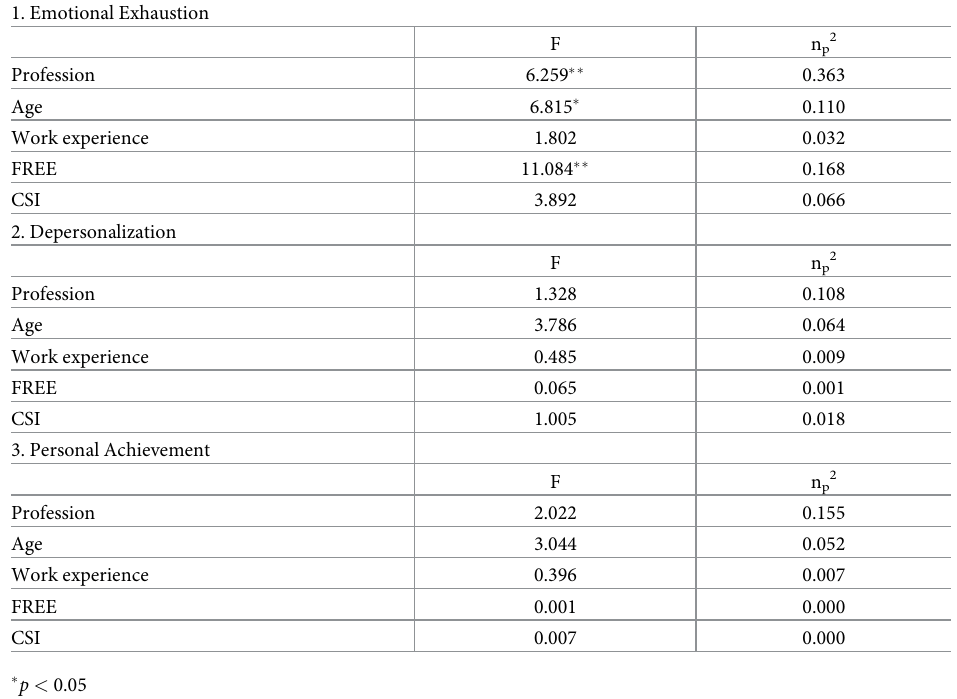
Table 3. Results of the ANOVA and ANCOVA for the three factors of the MBI. 1. Emotional Exhaustion